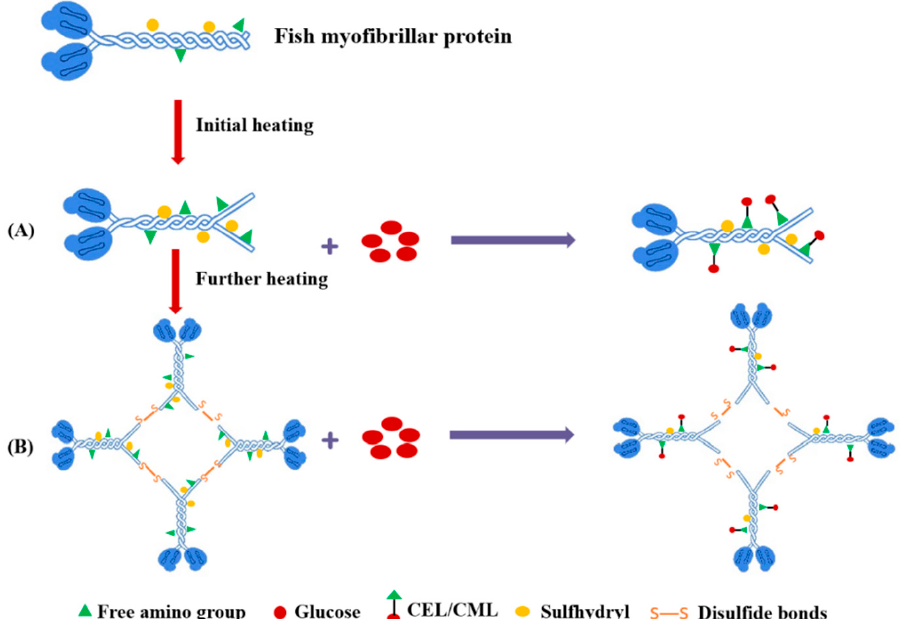
Figure 11. Possible mechanism for the effect of protein structure changes induced by the extent of thermal treatments on the formation of AGEs. ( A ) Initial heating. ( B ) Further heating.